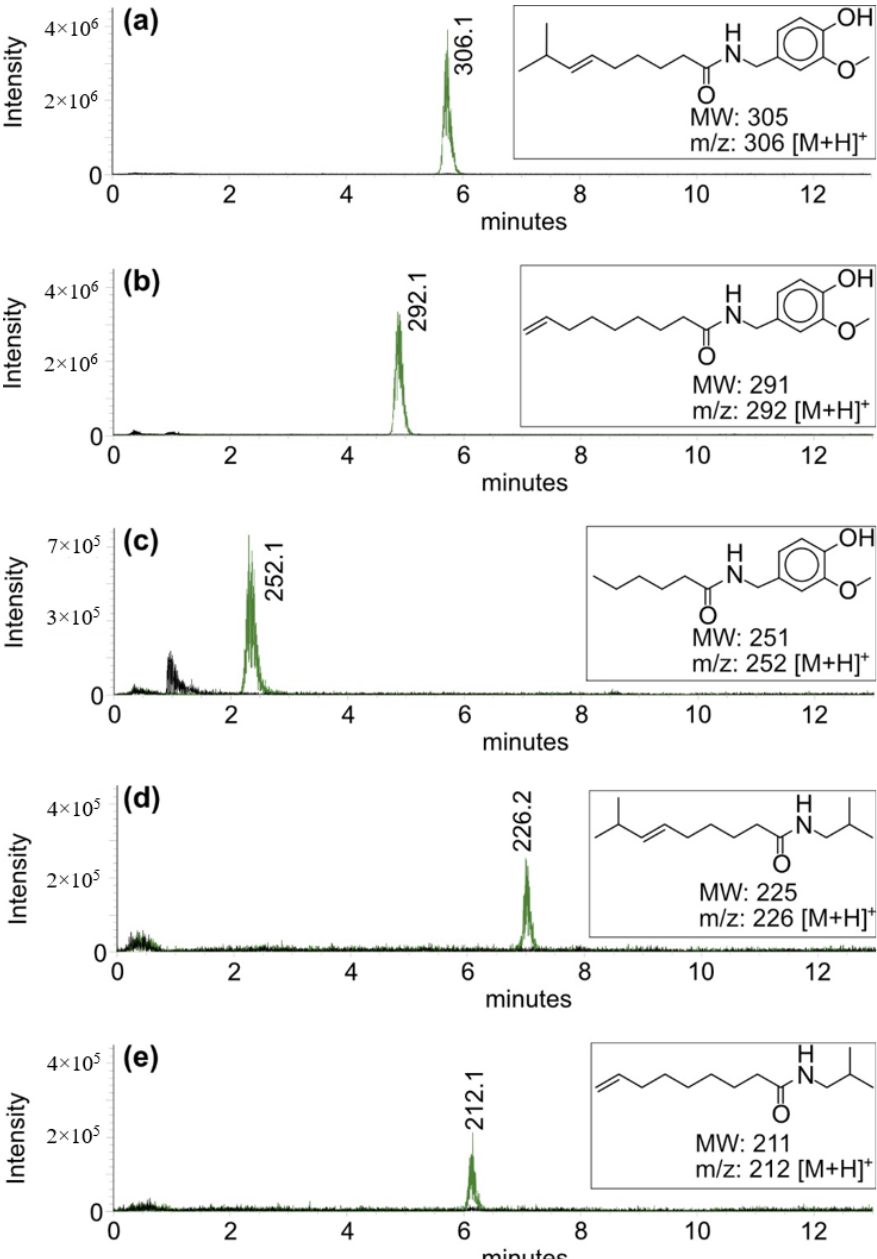
Figure 3. Product formation of recombinant capsaicin synthase with a set of aliphatic CoA-esters. Formation of ( a ), capsaicin; ( b ), 8-nonenoyl-vanilloylamide; ( c ), hexanoyl-vanilloylamide; ( d ), trans 8-methyl-6-nonenoyl-isobutylamide; ( e ), 8-nonenoyl-isobutylamide. Apparent kinetic constants were only determined for the natural substrate trans 8- methyl-6-nonenoyl-CoA and vanilloylamine. In the case of the CoA ester, the curve fits the classical Michaelis–Menten kinetics and the product yields dropped above 1 mM CoA substrate. In contrast, no matter how high the concentration of vanilloylamine (up to 25 mM in the assay), saturation with the substrate was never achieved. We also noticed that under the conditions used, a minimum concentration of 2 mM vanilloylamine was required for the recombinant enzyme reaction to proceed. Below this, even at longer incubation times, no product formation was observed at